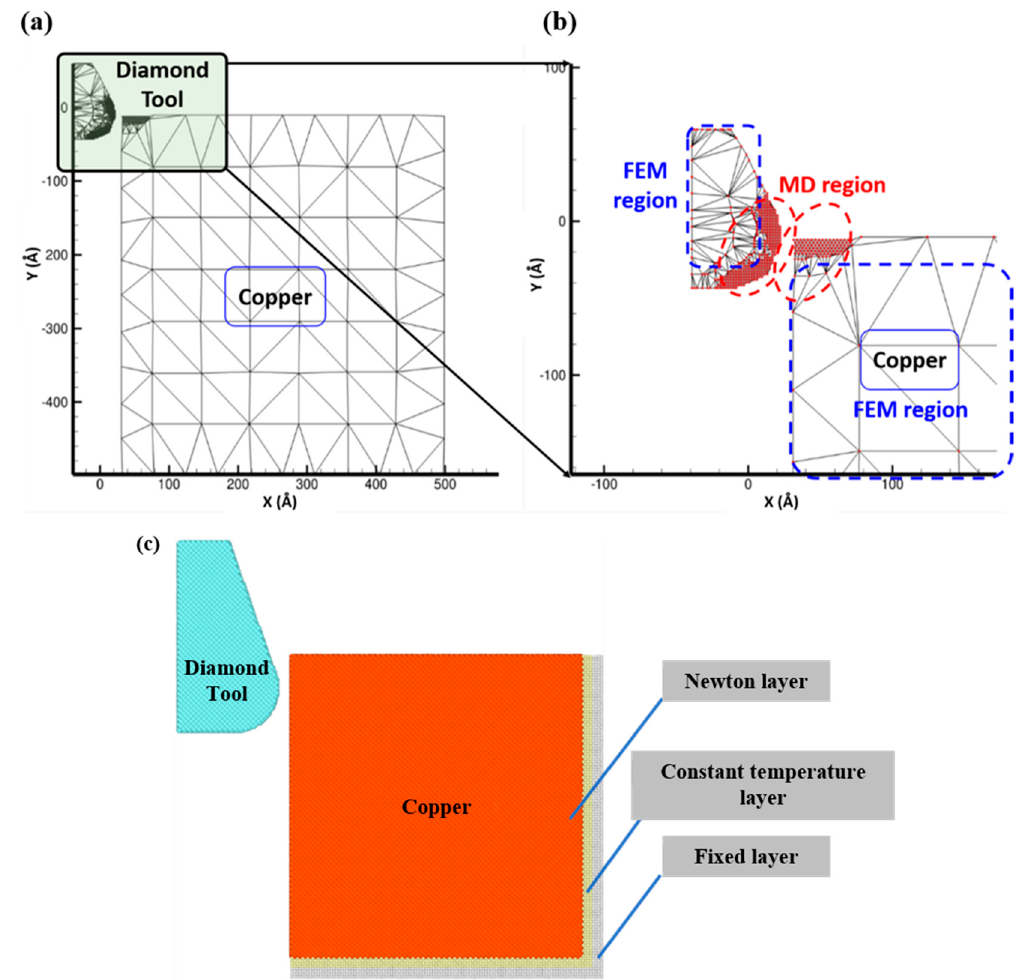
Figure 1. ( a ) The schematic diagram of multiscale cutting model for the nanocutting process of the copper sample; ( b ) zoom-in view of the interfacial contact between the diamond machining tool and the copper sample and ( c ) the schematic diagram of the MD cutting model for the nanocutting process of the copper sample.